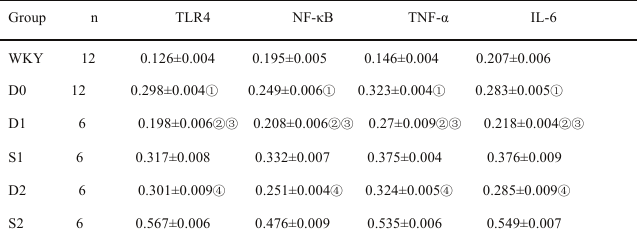
TABLE 2 - Semi-quantitative detection of protein expression of TLR4, NF-κB, TNF-α and IL-6 in the myocardium of rats in different groups ( sx ± ).